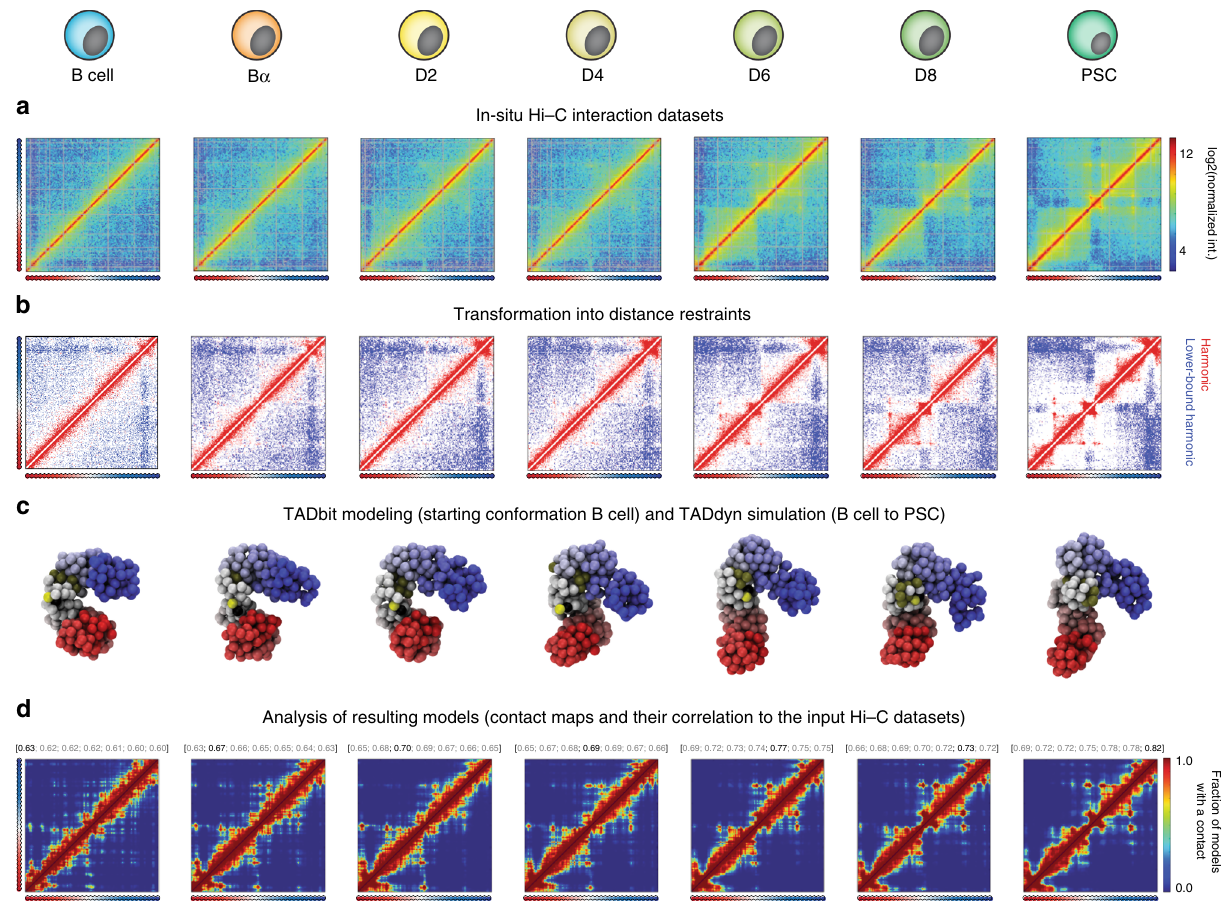
Fig. 1 The TADdyn key steps for simulating 4D dynamic changes in a locus. The shown example corresponds to the reprogramming dynamics for the Sox2 locus from B cells to PSC. a Data collection. In situ normalized Hi – C interaction matrices 35 for the region of 1.5 Mb centered around the Sox2 promoter. b Distance restraints de fi nition. Both LowerBound- (blue) and Harmonic (red) spatial restraints are obtained by fi ltering the Hi – C interaction maps using the optimal triplet of TADbit parameters ( “ Methods ” ). c TADdyn steered dynamics runs. The simulated regions are represented as polymers made of spherical particles each a 5 kb-bin of the input Hi – C matrix. Particles are colored from red ( fi rst particle) to blue (last particle of the modeled region). The TSS of the locus of interest is represented by a black particle and the promoter by green ones. The models for all the stages (that is, from B to PSC) were dynamically built by TADdyn. d Contact maps (dcutoff = 200 nm) of models during the simulation were used to assess their accuracy by means of its Spearman correlation coef fi cients (SCCs) with the Hi – C input matrices. The SCCs of the contact maps with the seven Hi – C input matrices are shown with the coef fi cient in bold black letters corresponding to the time point of the column. As our previous modelling benchmark indicates 41 , all the SCCs > 0.60, that are obtained between models and Hi – C maps at corresponding cell stages, are indicative of good models. In c, d, only the models and the contact maps at the correspondent experimental time-points are shown, but TADdyn allows to visualize the entire dynamics fi lling the blanks between stages as shown in the Supplementary Movies 1 –